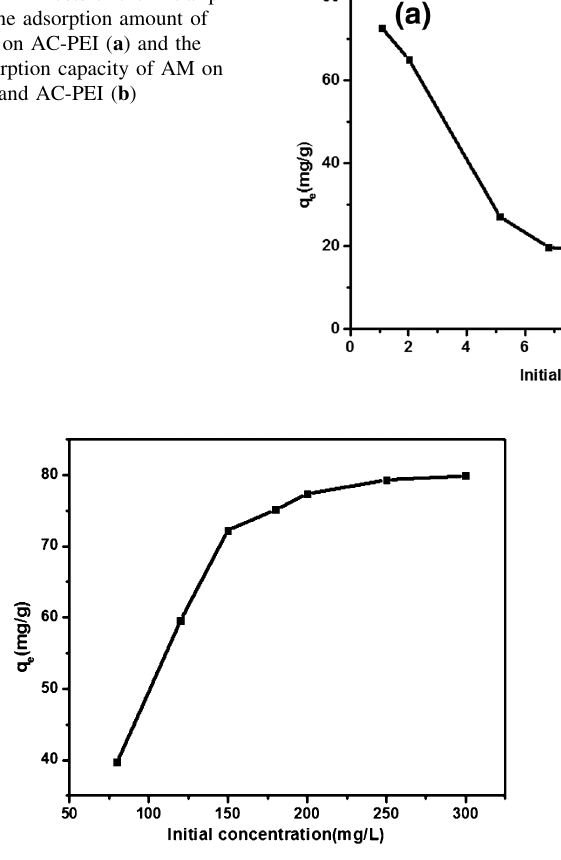
Fig. 5 The effect of initial AM concentrations on the adsorption Fig. 6 Effect of AC-PEI dosage on the AM adsorption